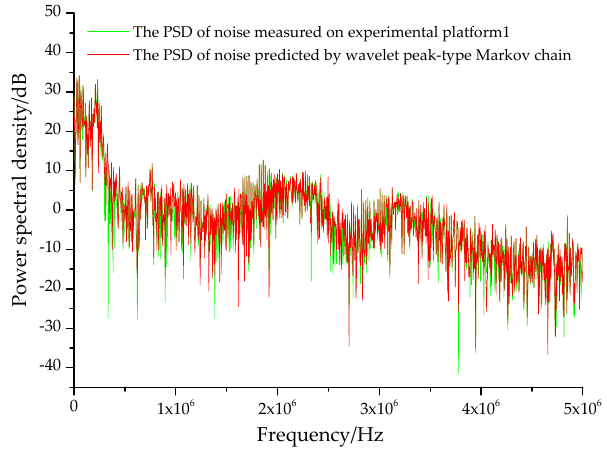
Figure 13. The power spectral density (PSD) of measured noise before and after modeling.